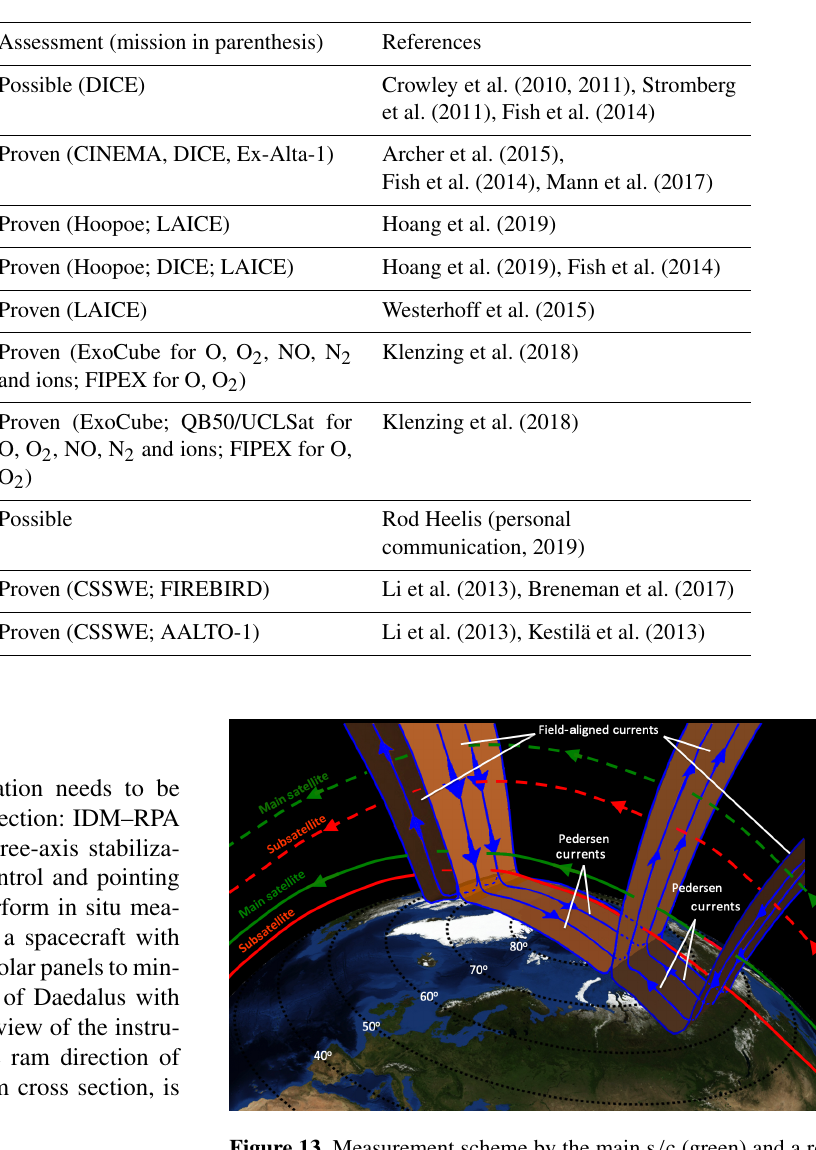
Figure 13. Measurement scheme by the main s / c (green) and a re- leased subsatellite (red) when apogee is at high latitudes (dashed lines) and when perigee is at high latitudes (solid lines) (adapted from figure by Gang Lu, the Comet Program,